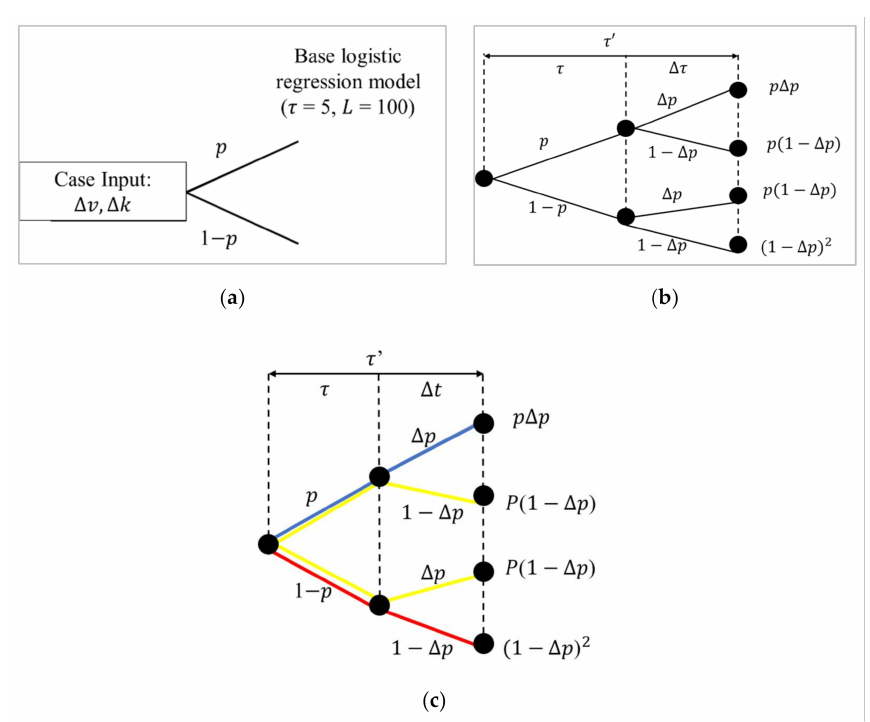
Figure 3. Schematic layout ( a ) the root of the base model, ( b ) overall event tree, ( c ) observing the presence of multiple-lane